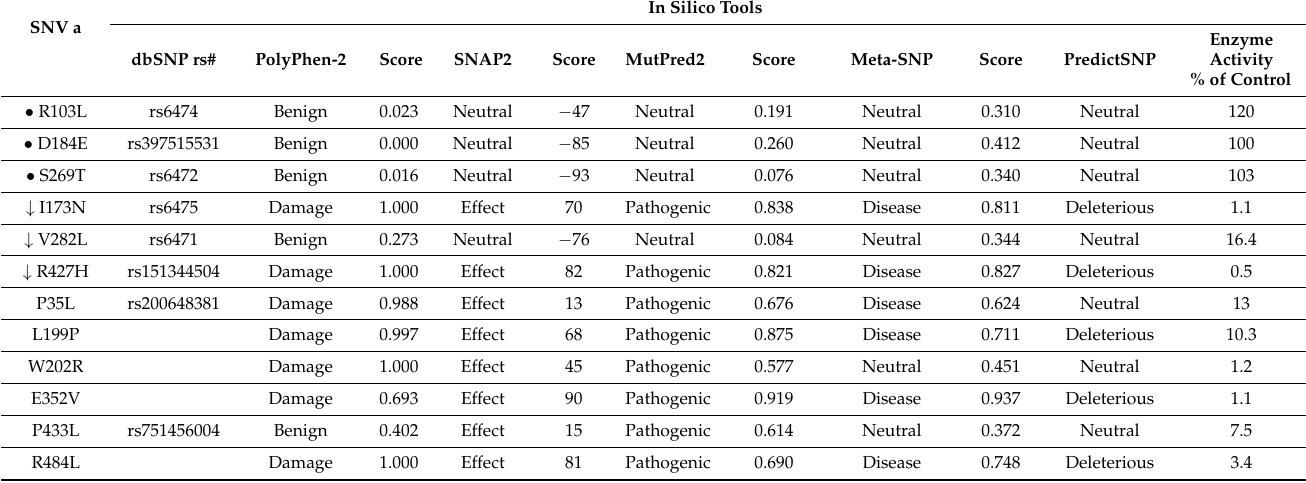
Table 2. Prediction of the possible impact on the structure and/or function of CYP21A2 by genetic variants. Seven variants were used to validate the method, with four polymorphisms ( • ) and